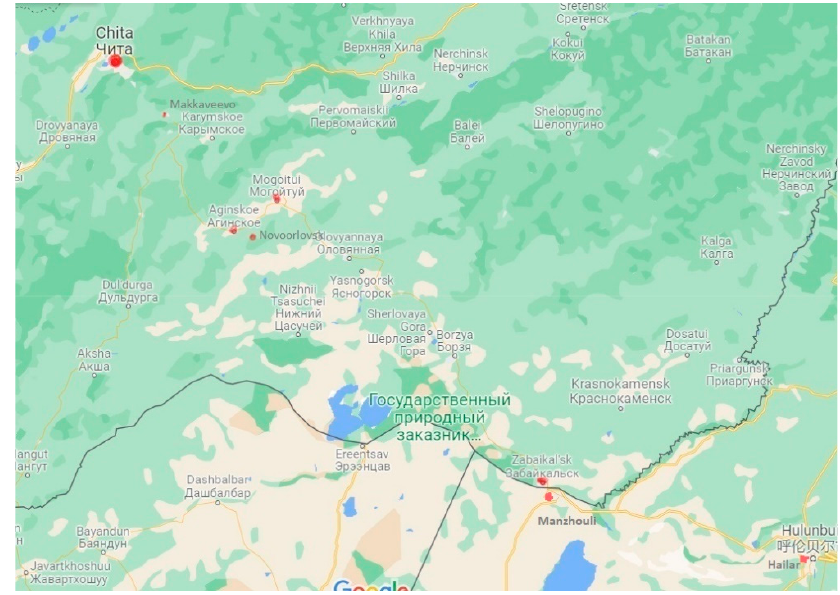
Figure 1. Map of locations visited during the field work.